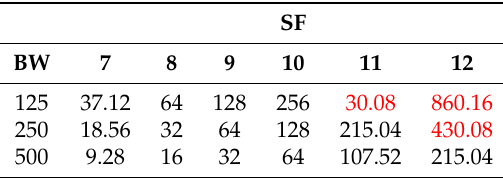
Table 6. Values of T packet , in ms, versus BW and SF, with CR = 1. The red color indicates values of the table that are not